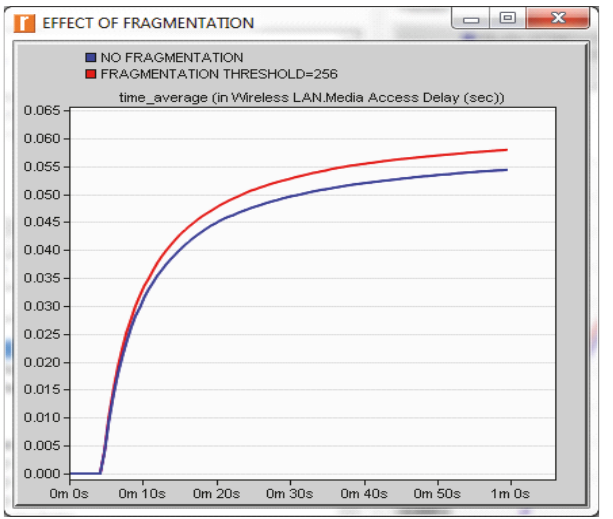
Figure 11: WLAN media access delay with and without fragmenta- tion.